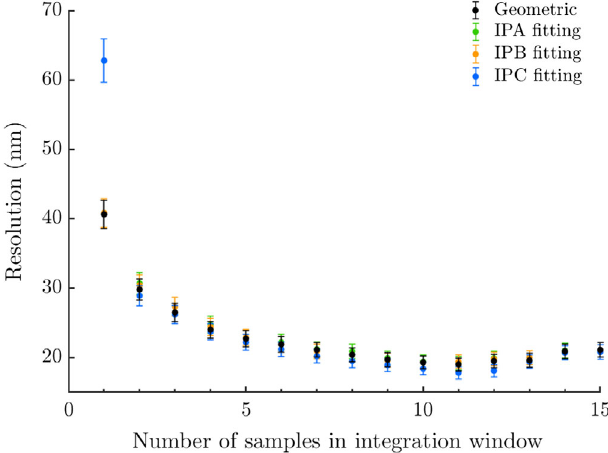
FIG. 11. Resolution vs number of samples integrated; the location of each integration window was chosen so as to optimize the geometric resolution. Results for the geometric (black) and fitting method for each BPM (green, gold, blue) are shown. The error bars represent the statistical uncertainty on the resolution.